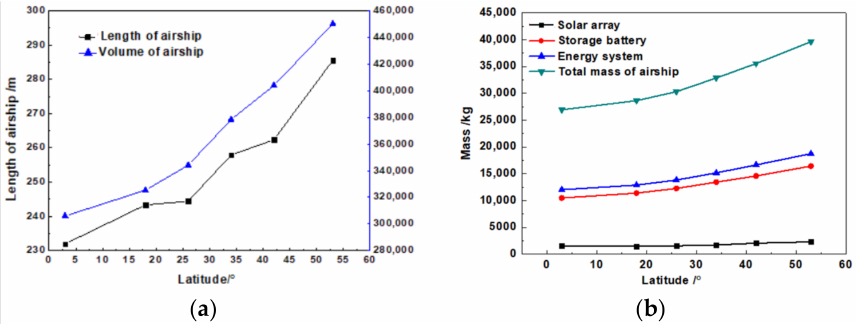
Figure 13. ( a ) Optimized volume and length of airship for different latitudes. ( b ) The mass of solar array, storage battery, energy system and total mass of the airship for different latitudes.